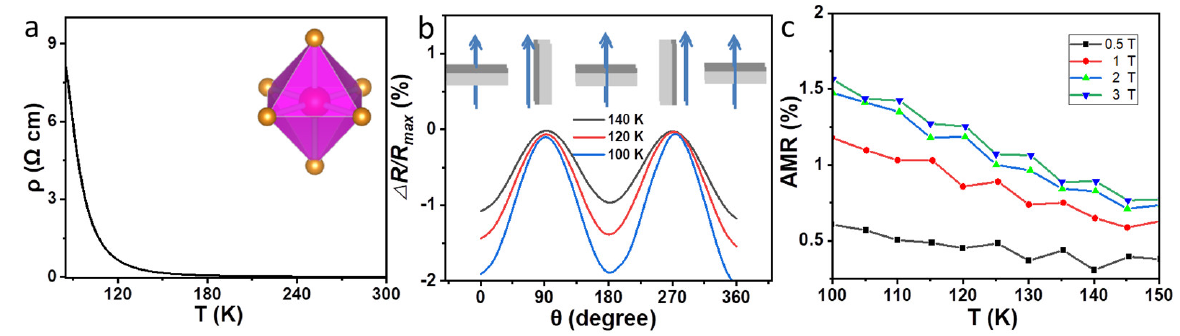
Figure 5. ( a ) Temperature − dependent resistance of a 4 nm Fe 3 O 4 thin film; ( b ) angular − dependent resistance for the 4 nm Fe 3 O 4 film measured at 3 T; ( c ) temperature − dependent AMR at different fields for the 4 nm Fe 3 O 4 film.